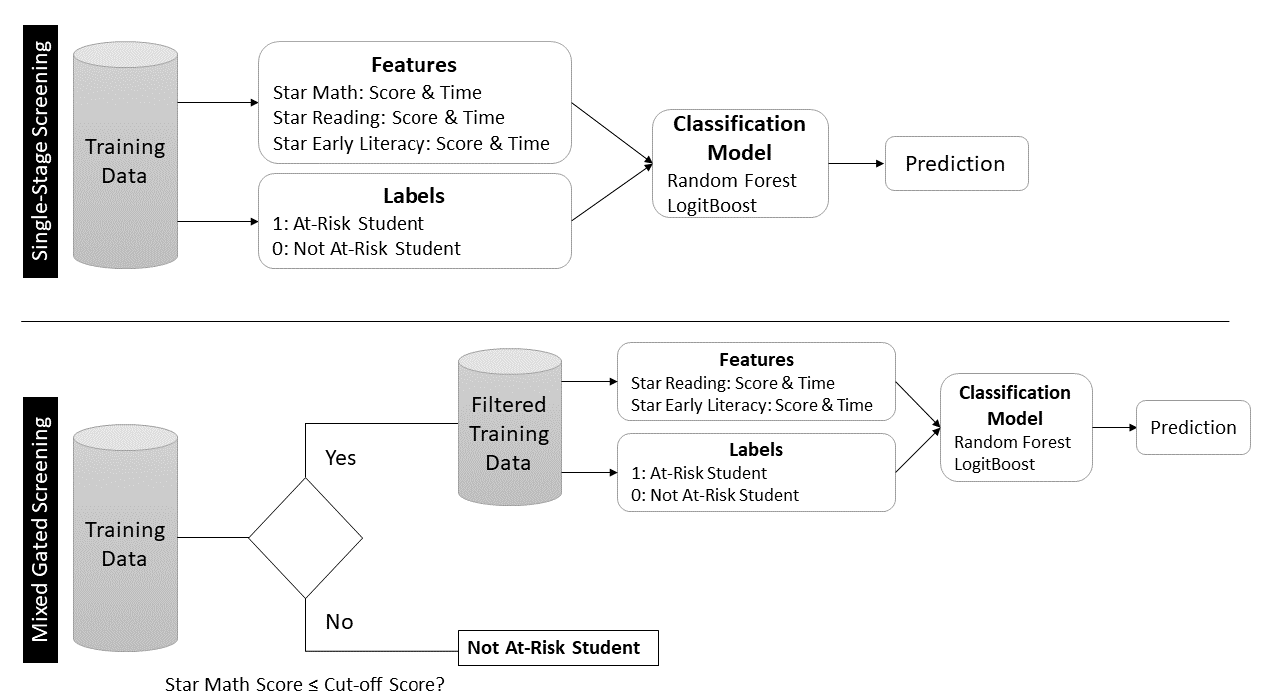
Figure 1. Single-stage and mixed gated screening